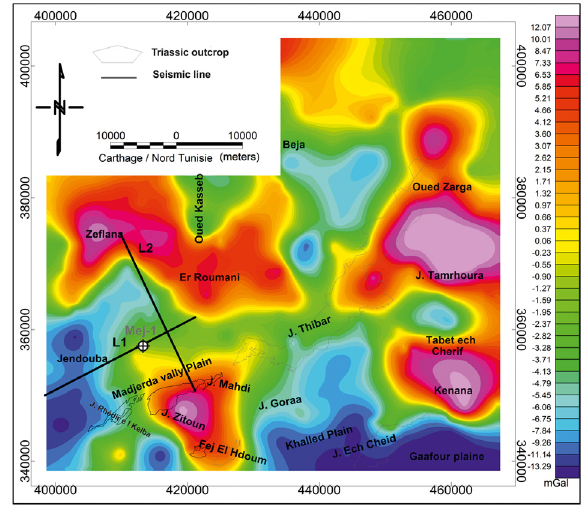
Figure 5. Complete Bouguer gravity anomaly map of the Thibar area (northern Tunisian